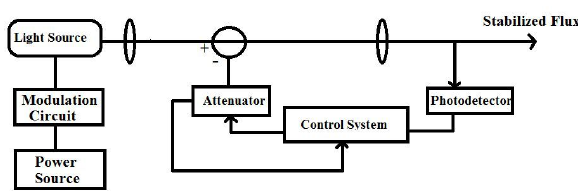
Figure 1 : Basic block diagram of the